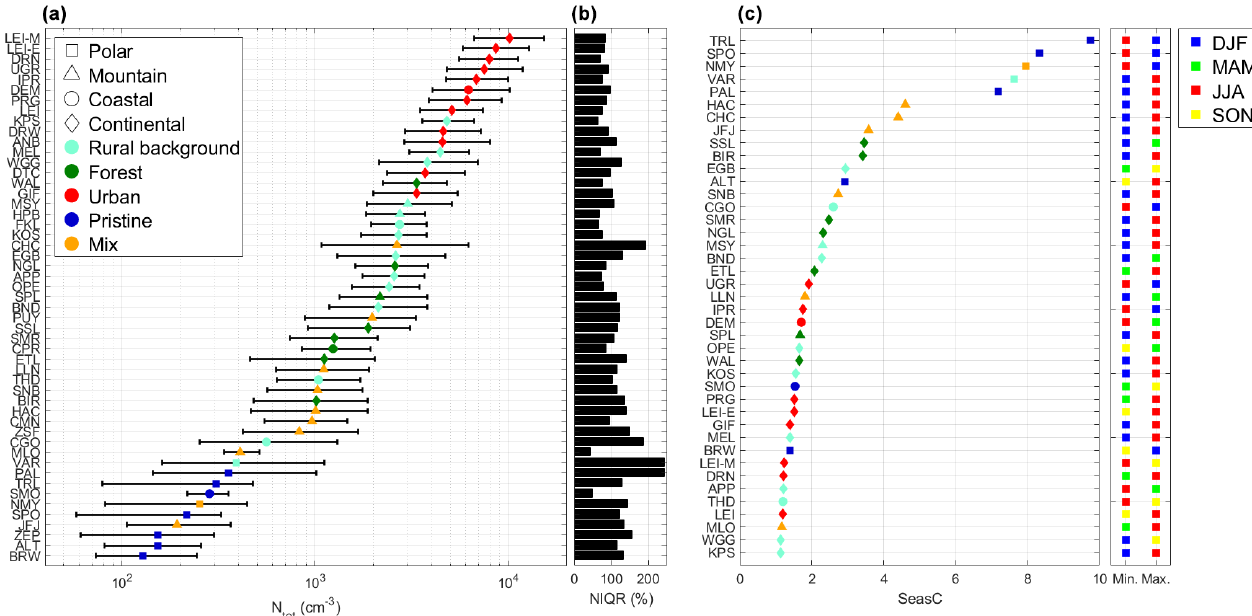
Figure 6. Ranking of the stations based on (a) the annual median of N tot and (c) the variable SeasC, used as a metric to evaluate the magnitude of the seasonal contrast of N tot . In (a) , the markers represent the median of N tot , and the left and right ends of the error bars represent the first and third quartile of the data, respectively. The annual variability of N tot is again shown in (b) by means of the NIQR calculated for each site displayed in (a) . Different symbols and colours in (a) and (c) indicate geographical and footprint categories, respectively. The right-hand side of (c) also shows the seasons corresponding to the minimum and maximum seasonal medians of N tot used in the calculation of SeasC. Additional explanations regarding the calculation and interpretation of SeasC and NIQR are available in Sect. 5.1.